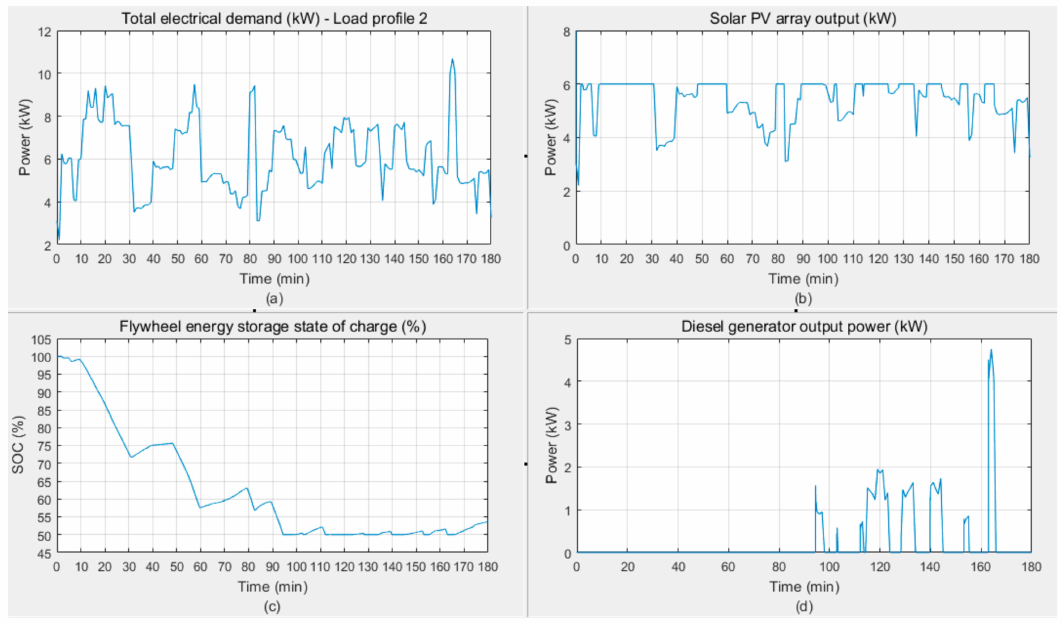
Figure 21. ( a ) Load profile 2. ( b ) PV array output power. ( c ) Flywheel initially at 100% state of charge. ( d ) Diesel generator output power.